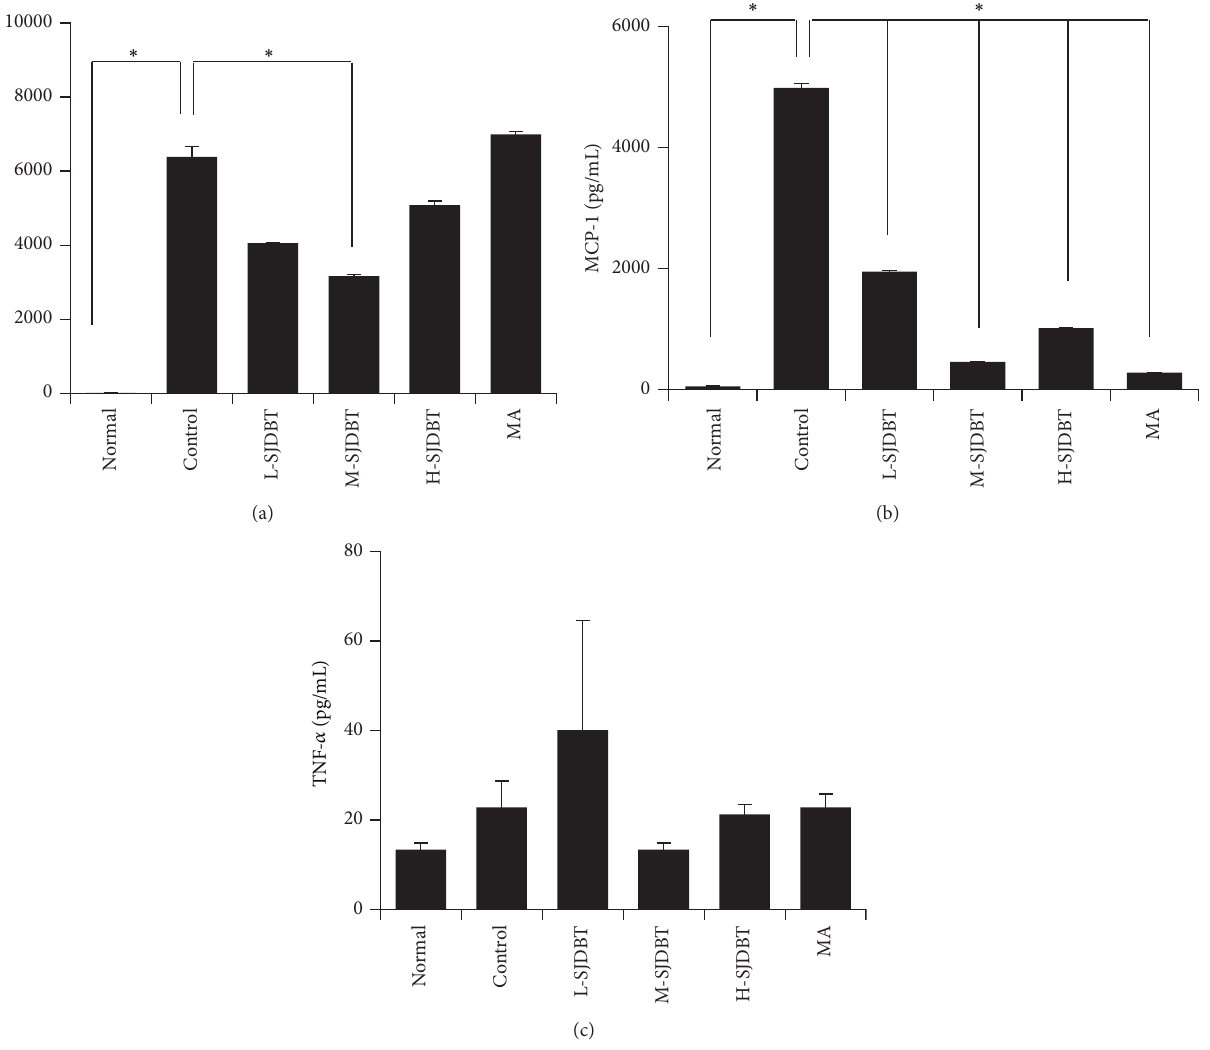
Figure 3: Effect of SJDBT on serums IL-6, MCP-1, and TNF- 𝛼 levels in CT-26 tumor-bearing mice. ((a), (b)) 21 days after tumor cell injection, SJDBT were p.o. administrated every day until 42 days. At the end of experiments, mice were sacrificed. Blood samples were collected by cardiac puncture and serum samples were obtained blood sample after centrifuged. IL-6, MCP-1, and TNF- 𝛼 level were measured using a Milliplex Mouse Metabolic Magnetic Bead Panel MMHMAG-44K-14. Experiments were performed in duplicate. Bars indicate means and standard deviations. ∗ 𝑃 < 0.05